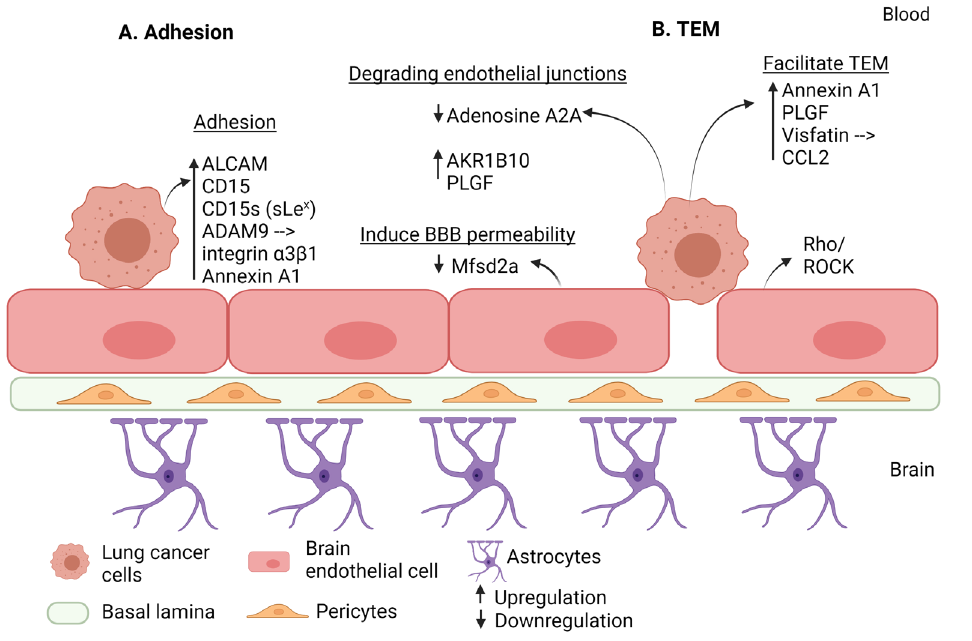
Figure 3. Schematic representation of extravasation steps in lung cancer brain metastasis. ( A ) Rolling and firm adhesion: During adhesion to BE, lung cancer cells express ALCAM, CD15, CD15s (sLex), annexin A1 and ADAM9 that upregulate integrin α3β1 [35,130,134]. ( B ) Trans-endothelial migration: During TEM, BECs downregulate the expression of Mfsd2a to induce permeability of BBB. Downregulation of adenosine A2A receptor in lung cancer cells activate SDF-1/CXCR4 signaling pathway and inhibits the expression of claudin-5, occludin, and ZO-1 [136]. Upregulation of AKR1B10, degrades (ZO-1 and VE- cadherin) and increases the levels of MMP2 and MMP9 [137]. BE Rho/ROCK signaling facilitates TEM with subsequent disruption of (occludin, claudin-5, and ZO-1) [139]. PLGF disrupts occludin and ZO-1 through interacting with its receptor, VEGFR-1 [140]. Visfatin upregulates CCL2 to promote TEM [142]. Photo created with BioRender.com. Table 4. Factors that mediate extravasation during brain metastasis of lung cancer.